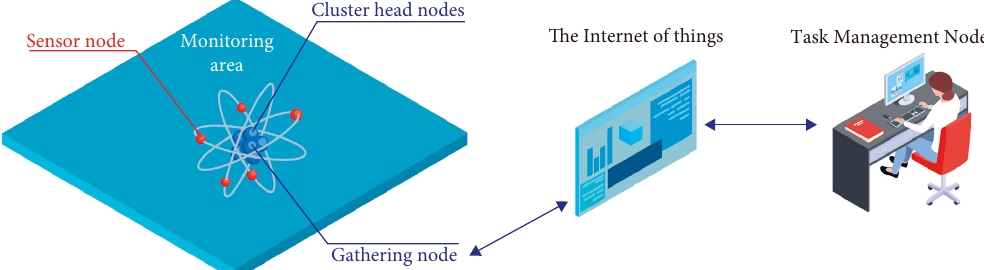
Figure 1: Environmental information collection, separation, and purification method framework for the extraction of coumarin com- pounds from Trifolium chinensis